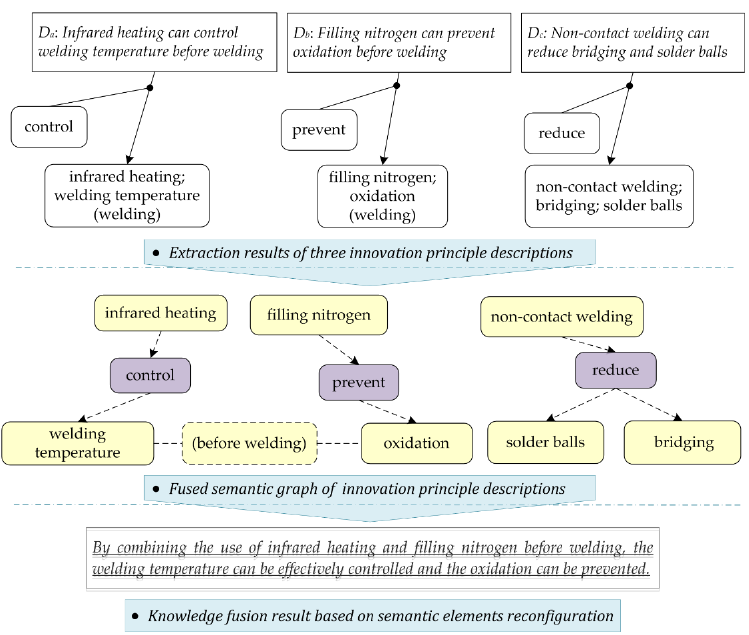
Figure 7. A fusion example of process innovation principle descriptions.